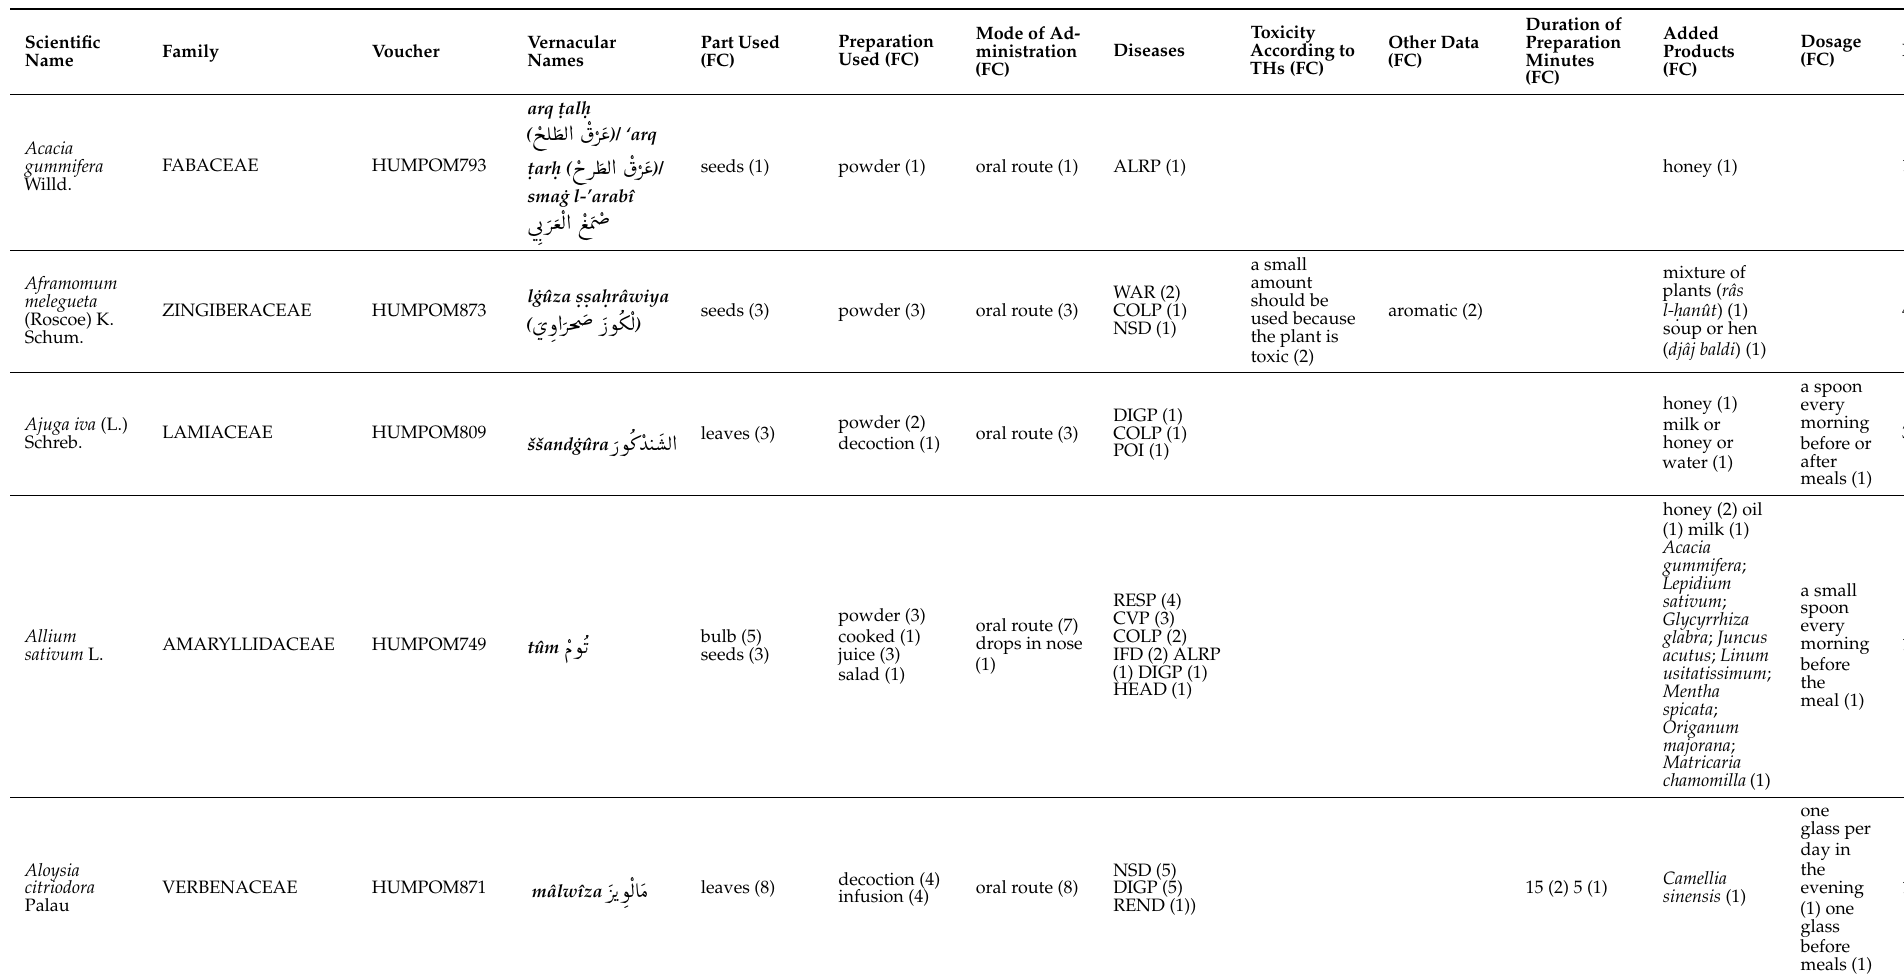
Table 3. Medicinal plants of Eeastern Morocco by THs, use, part used, preparation, route of administration, categories of diseases, toxicity, other data and the importance for each species according to the FC (frequency of